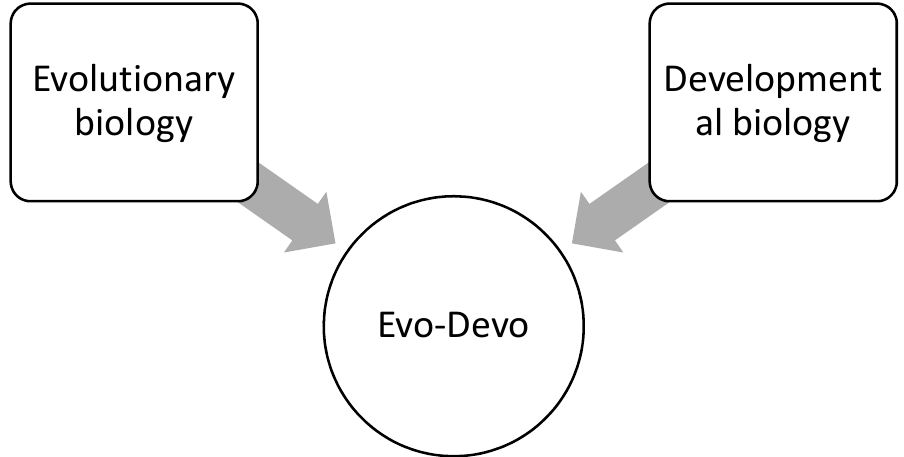
Figure 2. The emergence of evo-devo from the convergence of evolutionary and developmental biology (see Section 4.2 for details).